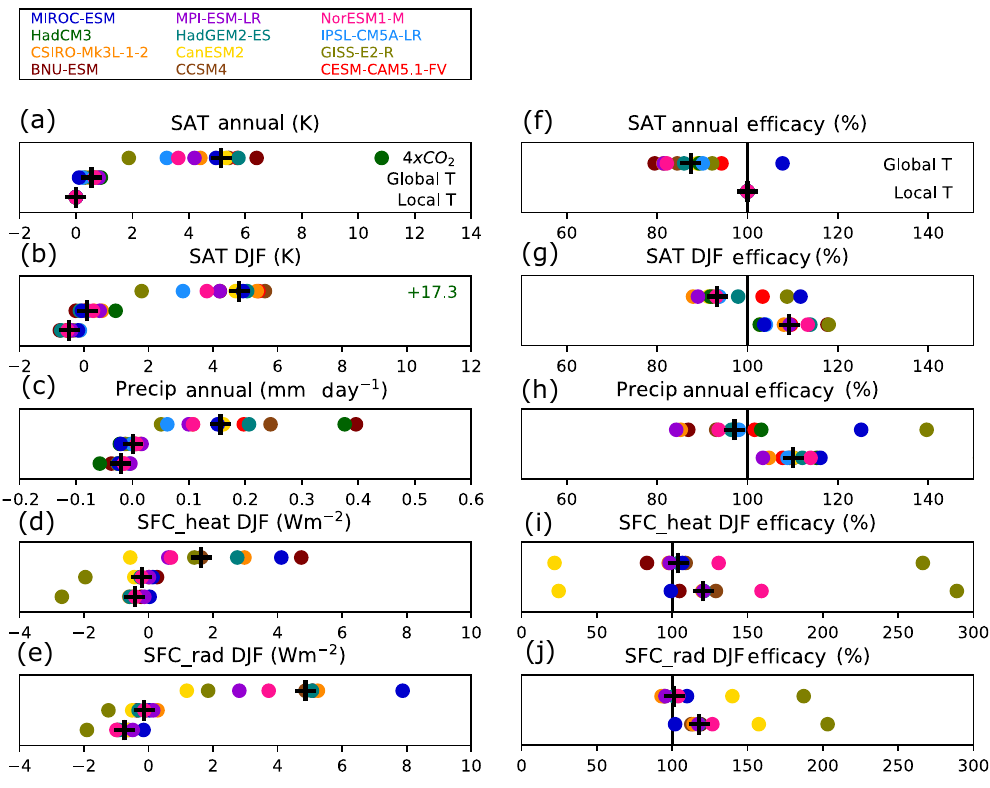
Figure 2. As in Fig. 1 but for Antarctica and Antarctic